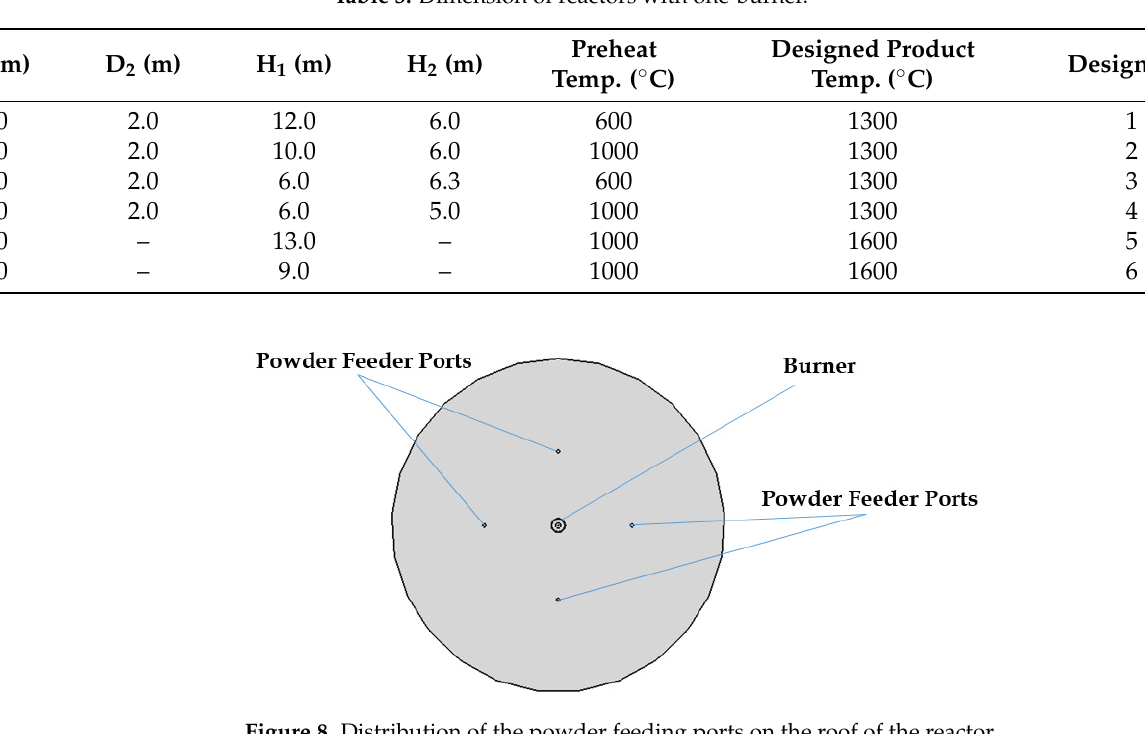
Figure 7. Sketches of possible configurations of flash ironmaking reactors. Table 3. Dimension of reactors with one-burner.